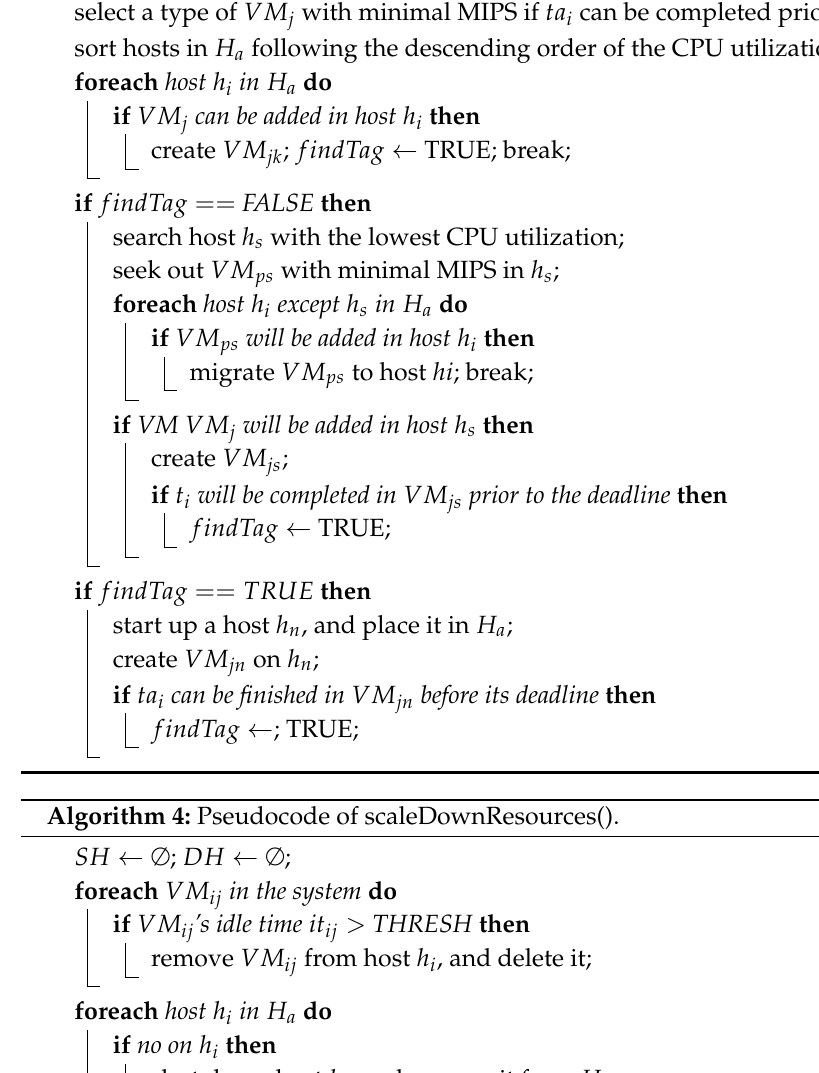
Algorithm 3: Pseudocode of scaleUpResources().